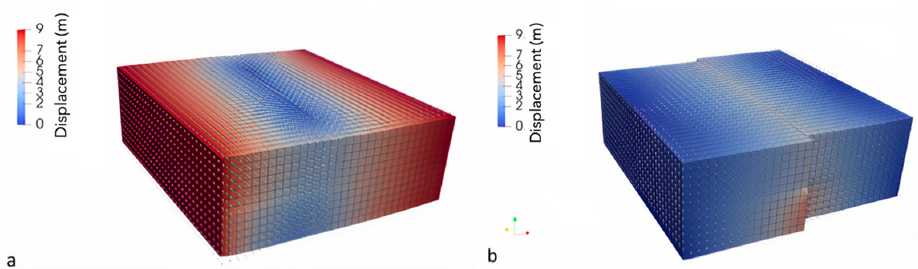
Figure 3. Displacement model for scenario one: ( a ) the strain buildup model at time simulation of 250 years using friction coefficient 0.6 and cohesion 2 MPa; ( b ) the strain release model using slip 7.575 m.